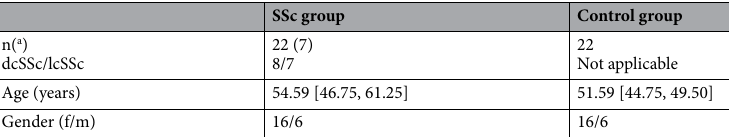
Table 1. Age and gender distribution of the systemic sclerosis (SSc) group and control group. Data are presented as median [25th, 75th percentile]. a Subgroup of patients with very early disease (VEDOSS); dcSSc = patients with diffuse cutaneous SSc; lcSSc = patients with limited cutaneous